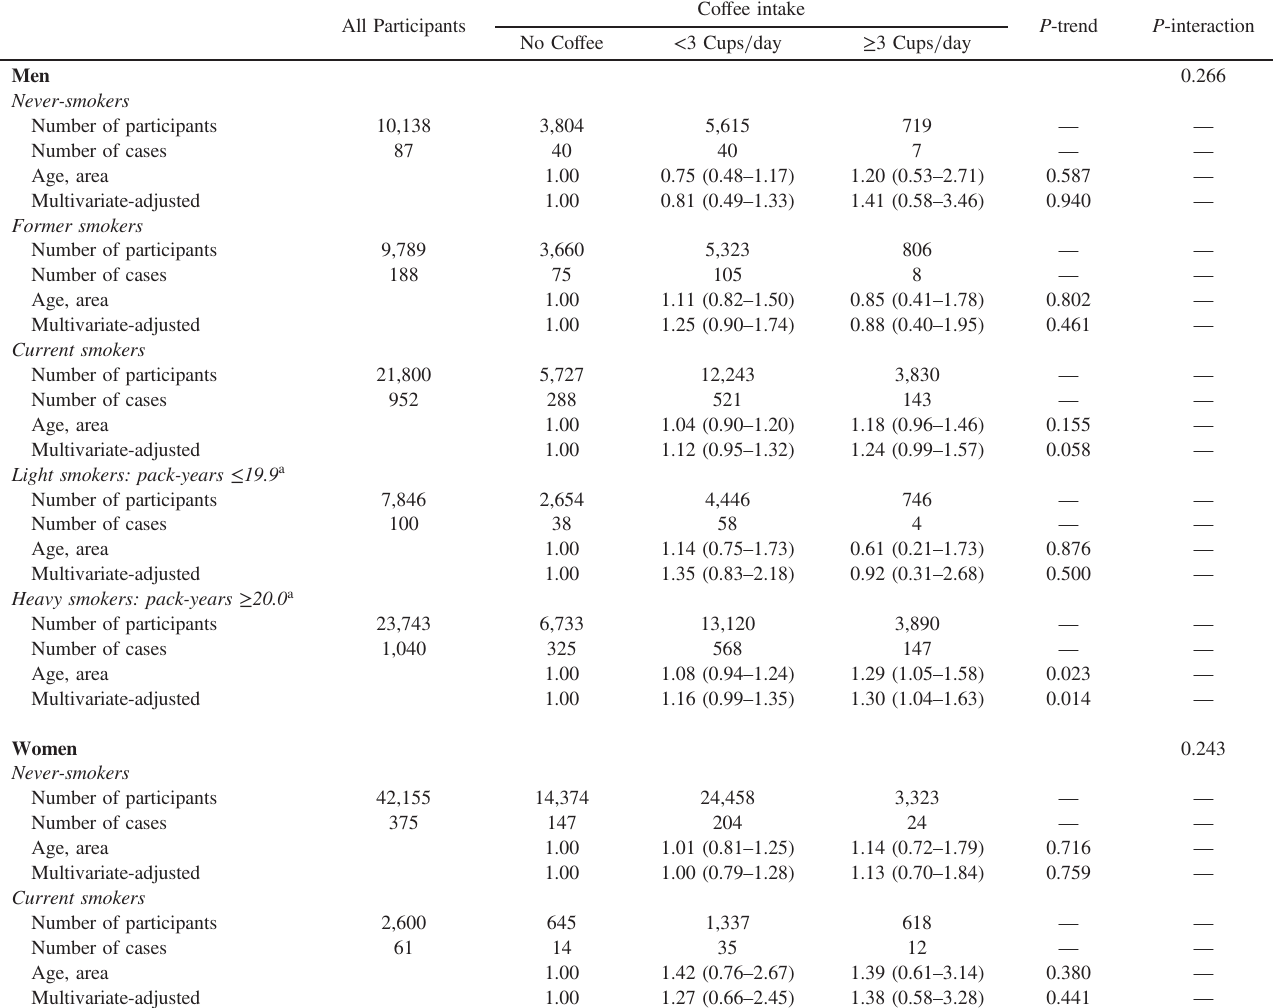
Table 3. Subgroup analysis by smoking status: hazard ratios (95% con fi dence intervals) for lung cancer incidence by daily co ff ee